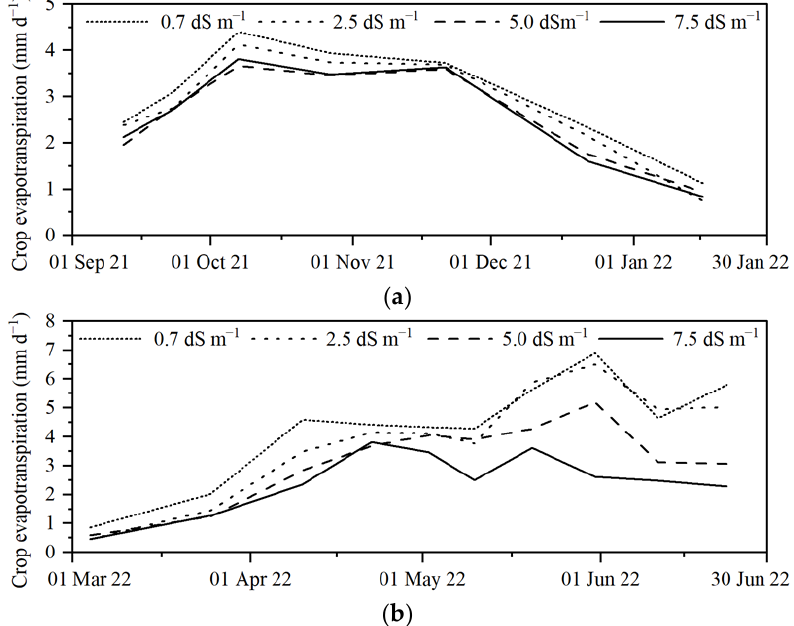
Figure 3. Changes in daily crop evapotranspiration values under different water salinity levels throughout the growing seasons; ( a ) autumn 2021 and ( b ) spring 2022.